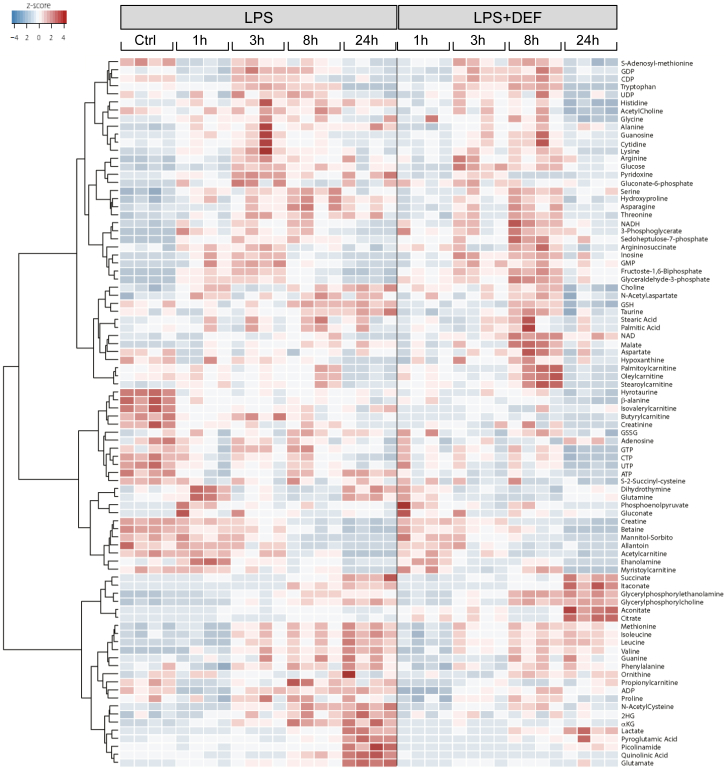
Acute Iron Chelation and Time Course Metabolomics in LPS-Stimulated Human MacrophagesHeatmap for LC-MS analysis of 88 metabolites in basal (Ctrl), LPS treated (1, 3, 8, and 24 h) and LPS + DEF-treated human macrophages; DEF treatment is 500 μM, 24 h; n = 4 donors.